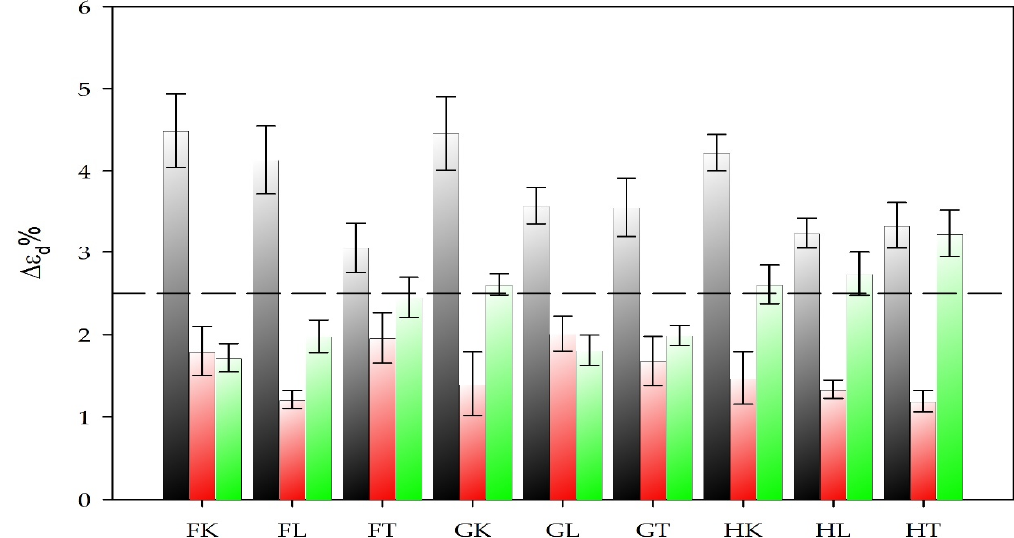
Figure 4. Dimensional stability of di ff erent oil-impregnated BcBs at hardening temperatures: Figure 4. Dimensional stability of different oil-impregnated BcBs at hardening temperatures: 40 Figure 4. Dimensional stability of different oil-impregnated BcBs at hardening temperatures: 40 °C, 90 °C, 120 °C. F, G and H—BcB composition, K—hempseed oil, L—linseed oil, T—tung °C, 90 °C, 120 °C. F, G and H—BcB composition, K—hempseed oil, L—linseed oil, T—tung 90 ◦ C, 120 ◦ C. F, G and H—BcB composition, K—hempseed oil, L—linseed oil, T—tung tree oil, °C, 90 °C, 120 °C. F, G and H—BcB composition, K—hempseed oil, L—linseed oil, T—tung tree oil, and Δε d—the change in thickness. tree oil, and Δε d—the change in thickness. and ∆ ε d—the change in tree oil, and Δε d—the change in thickness.